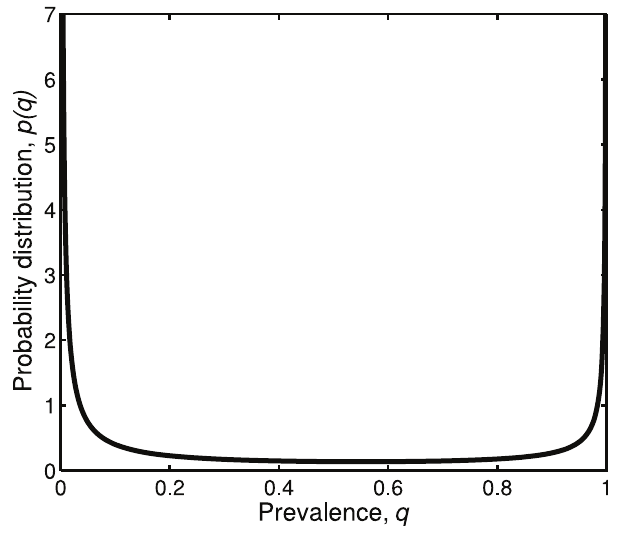
Figure 1. Estimated probability distribution of Wolbachia